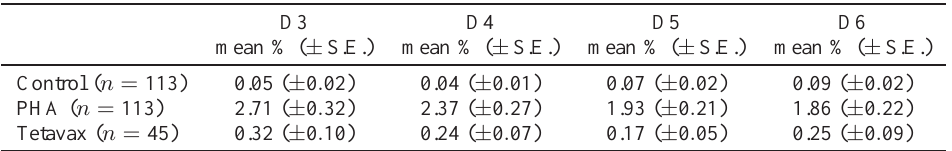
Fig. 3. Tetavax (cid:210) proliferative response profiles of peripheral blood mononuclear cells from three individual patients, assessed by flow cytometric evaluation of the percentage of cells in the S phase on days 3, 4, 5 and 6 of culture. The kinetics are clearly different, maximal stimulation occurs at different time points, and might go unnoticed if using a single time point evaluation. Table 2 Sequential assessment of the percentage of cells in G2+M among peripheral blood mononuclear cells cultured for 3, 4, 5 or 6 days with medium alone, PHA or Tetavax